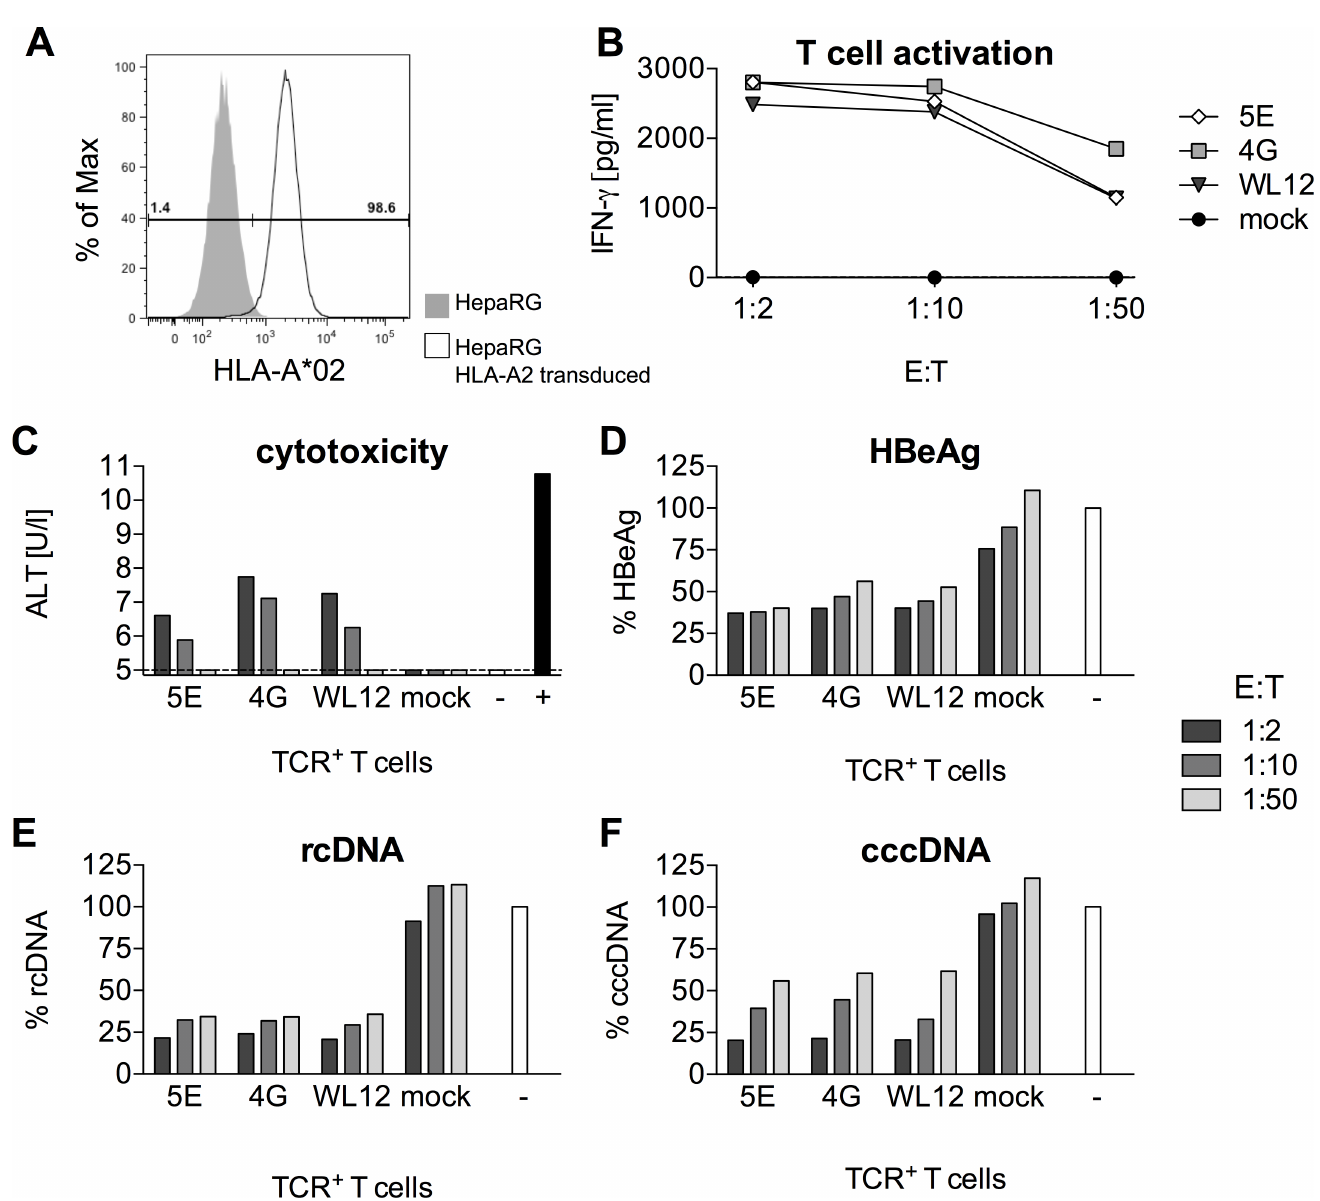
Fig 7. Recognition of HBV-infected cells by TCR-transduced T cells. (A) Expression of HLA-A * 02 on HepaRG target cells determinedby flow cytometry. (B-D) HBV-infected HepaRG cells were co-cultured with decreasingnumbers of TCR-transduced T cells for 44 hours. One TCR per peptide specificity was selected(5E: C18-specific,4G: S20-specific, WL12: S172-specific). Mock = untransduced PBMC,— = medium control without PBMC. (B) T-cell activationmeasuredby releaseof IFN- γ into the supernatant. (C) Alaninetransaminase (ALT) released from dying hepatocytes. Supernatants from triplicate co-cultures per TCR were pooledfor this analysis.+ = Triton-X, positive control for cell lysis. (D) HBeAg in the supernatant was measured using a diagnosticELISA. (E) Intracellular viral rcDNA and (F) nuclear cccDNA on day two were determinedusing qPCR. Values were normalized to the untreated medium control. Data are presentedas mean values +/- SEM from